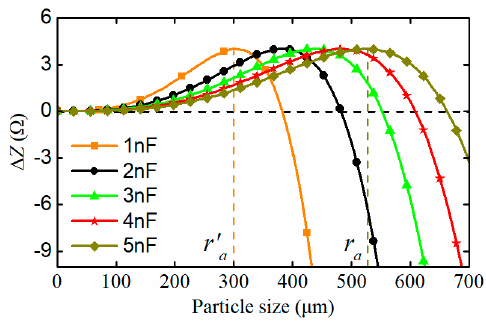
Figure 4. Impedance difference between exciting circuits of the proposed sensor with different resonant capacitors.